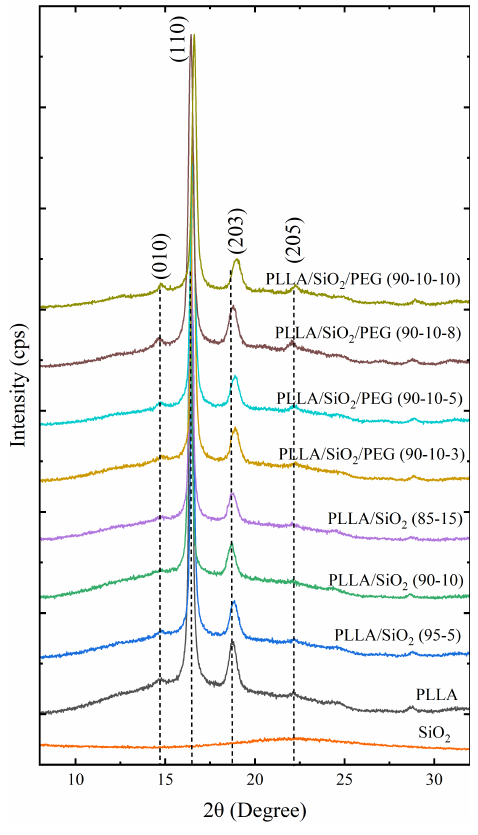
Figure 12. XRD patterns of PLLA, PLLA/SiO 2 , and PLLA/SiO 2 /PEG. Table 10. Crystallinity (Xc) of PLLA, PLLA/SiO 2 , and PLLA/SiO 2 /PEG obtained from XRD patterns and